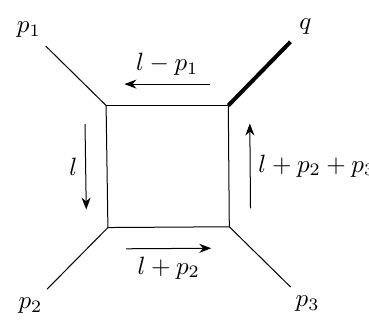
Figure 1 . The massless scalar box diagram with one off-shell external particle carrying momentum q . It is p 2 = p 2 = p 2 = 0 and q 2 6 = 0 . All external momenta are taken to be incoming. Drawn with 1 2 3 Ti k Z-Feynman